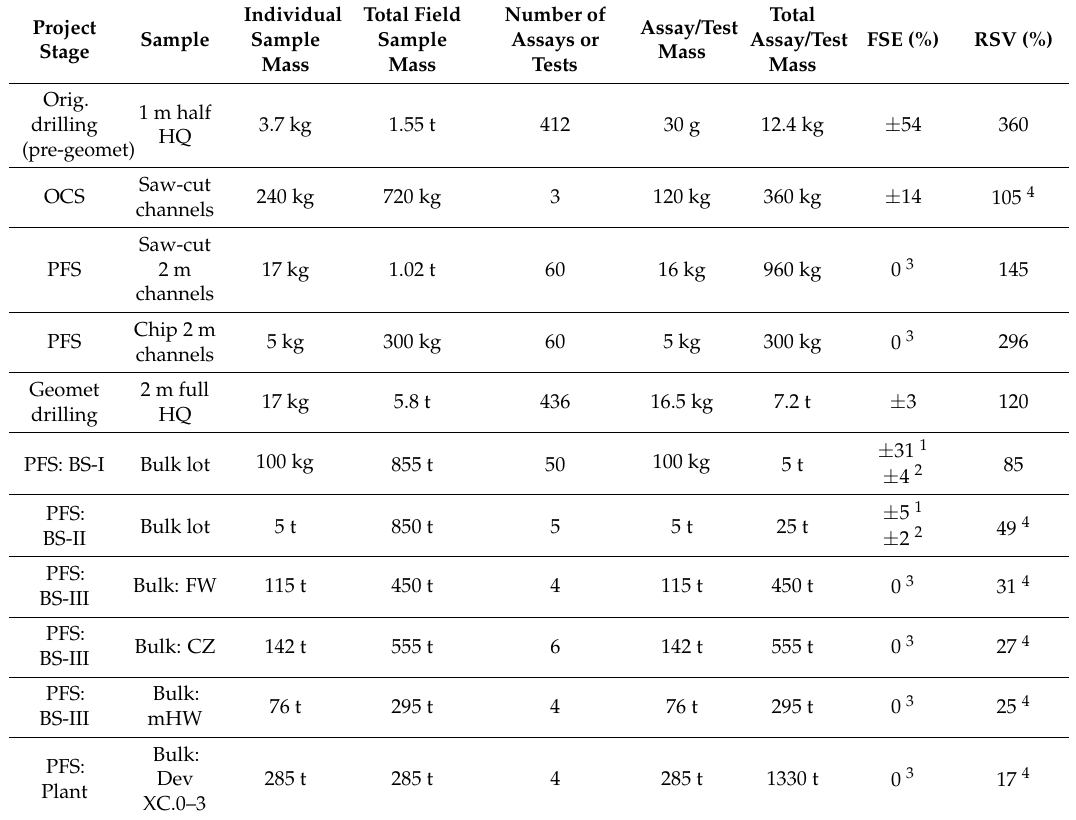
Table 18. Summary of sample type and mass, and FSE and RSV for different stages of SVZ evaluation. Project Stage